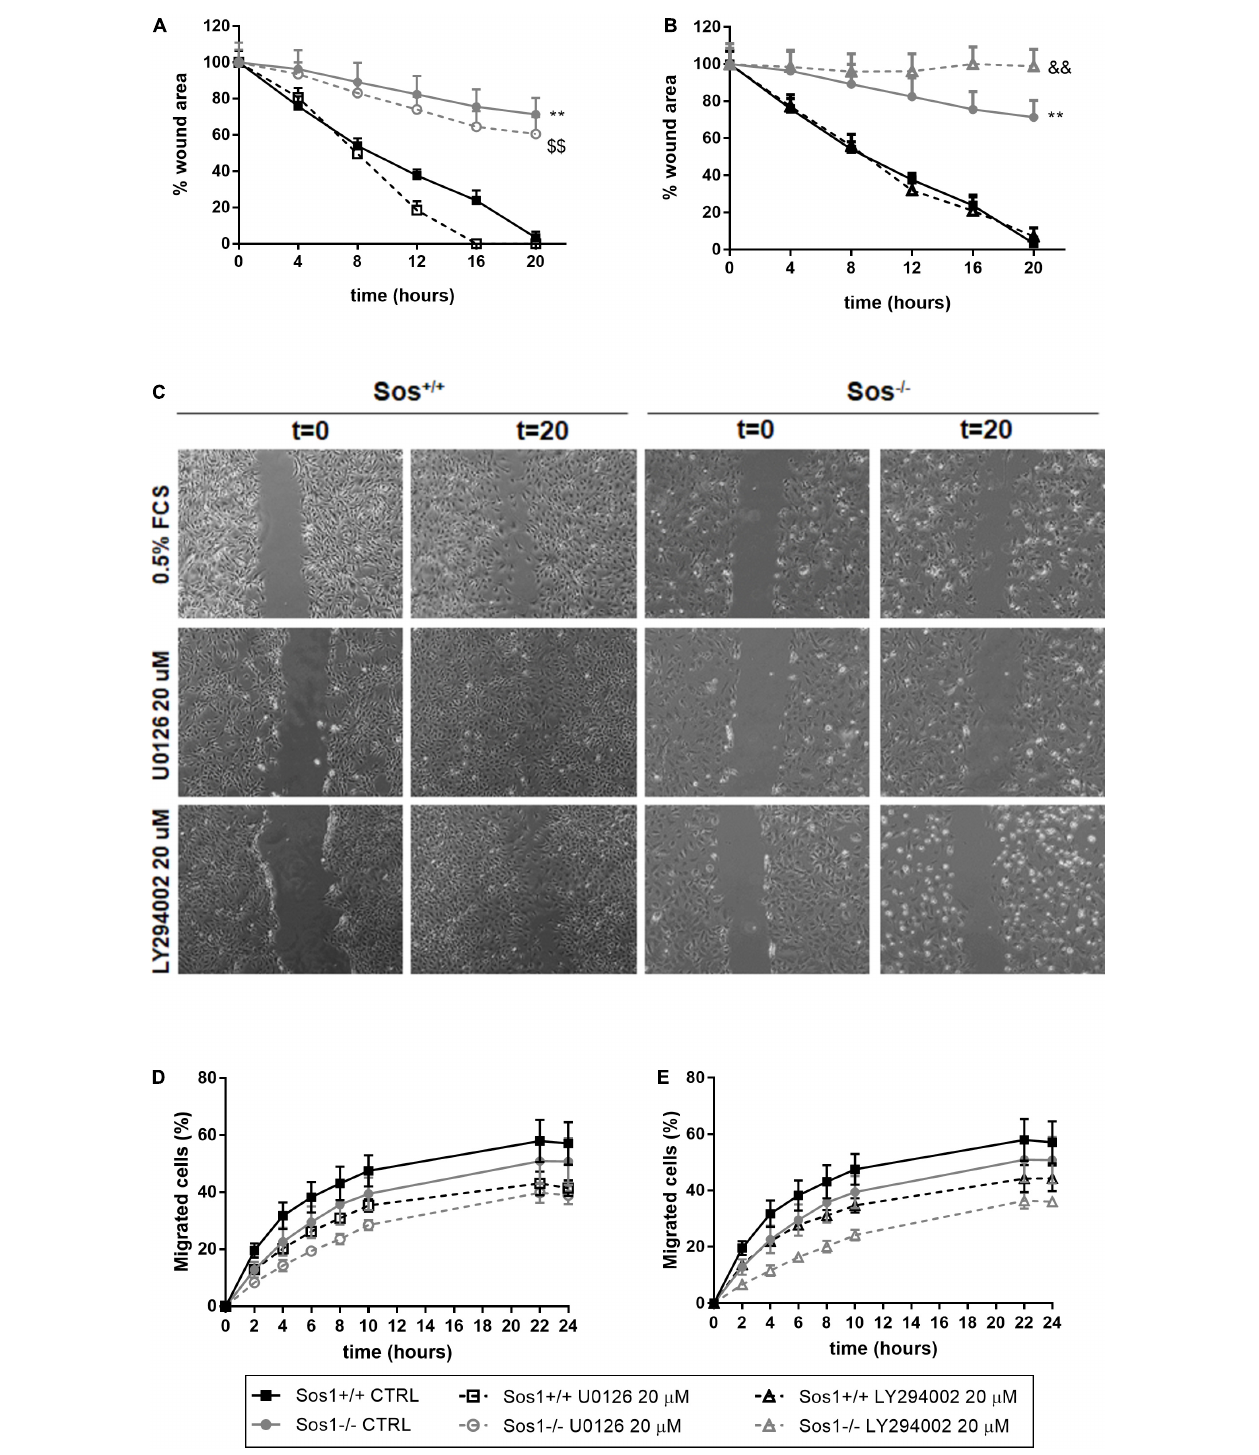
FIGURE 4 | Effect of Sos-1 deficiency on fibroblast migration. Analysis of cell mobility measuring wound closure area (A–C) and migration through transwells in a Boyden chamber (D,E) , and effect of MEK/Erk inhibition with 20 µ g/mL U0126 (A,D) or PI3K/Akt inhibition with 20 µ g/mL U0126 (B,E) in Sos-1 KO fibroblast migration; (C) shows representative images (50x) of wound closure at 0 and 20 h. Curve graphs in panels (A,B) represent the mean ± S.E.M. of 7 experiments of the time-course reduction of wound area (initial scratched area: 100%). Curve graphs in panels (D,E) represent mean ± S.E.M. of 6 experiments quantifying the migrated calcein-AM fluorescent cells expressed as percentage vs. total number of cells ( t = 24 h, 100%). Statistically significant differences: ** p < 0,01 vs. Sos1 + / + fibroblasts in basal conditions; $$ p < 0,01 vs. Sos1 + / + fibroblasts treated with U0126; && p < 0,01 vs. Sos1 + / + fibroblasts treated with LY294002.